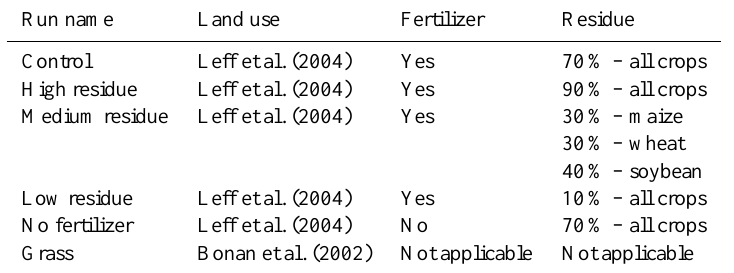
Table 1. CLM-Crop simulations performed. Run name Land use